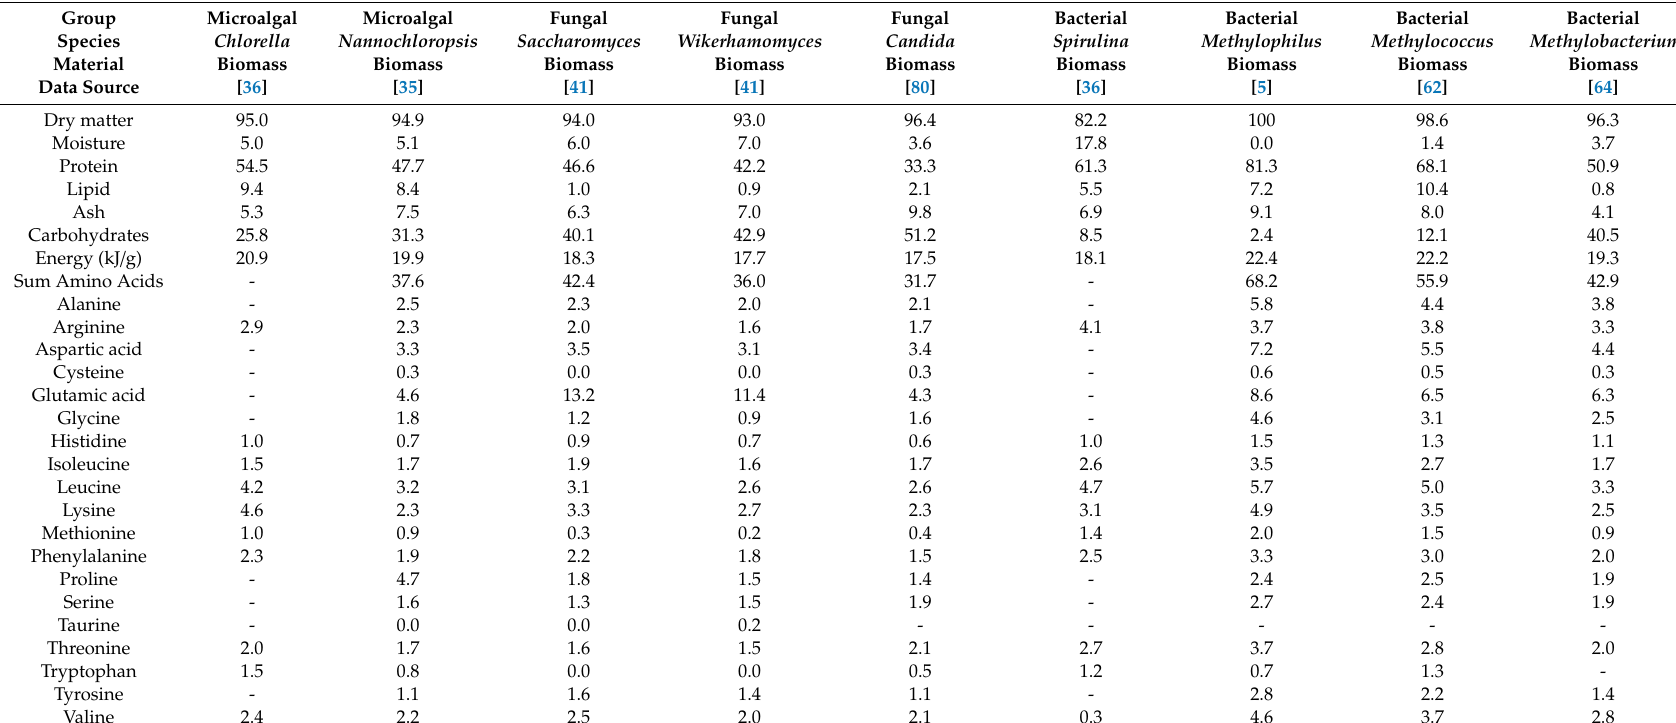
Table 2. Proximate and Amino Acid analysis of various SCP resources. All values % as supplied unless otherwise detailed.